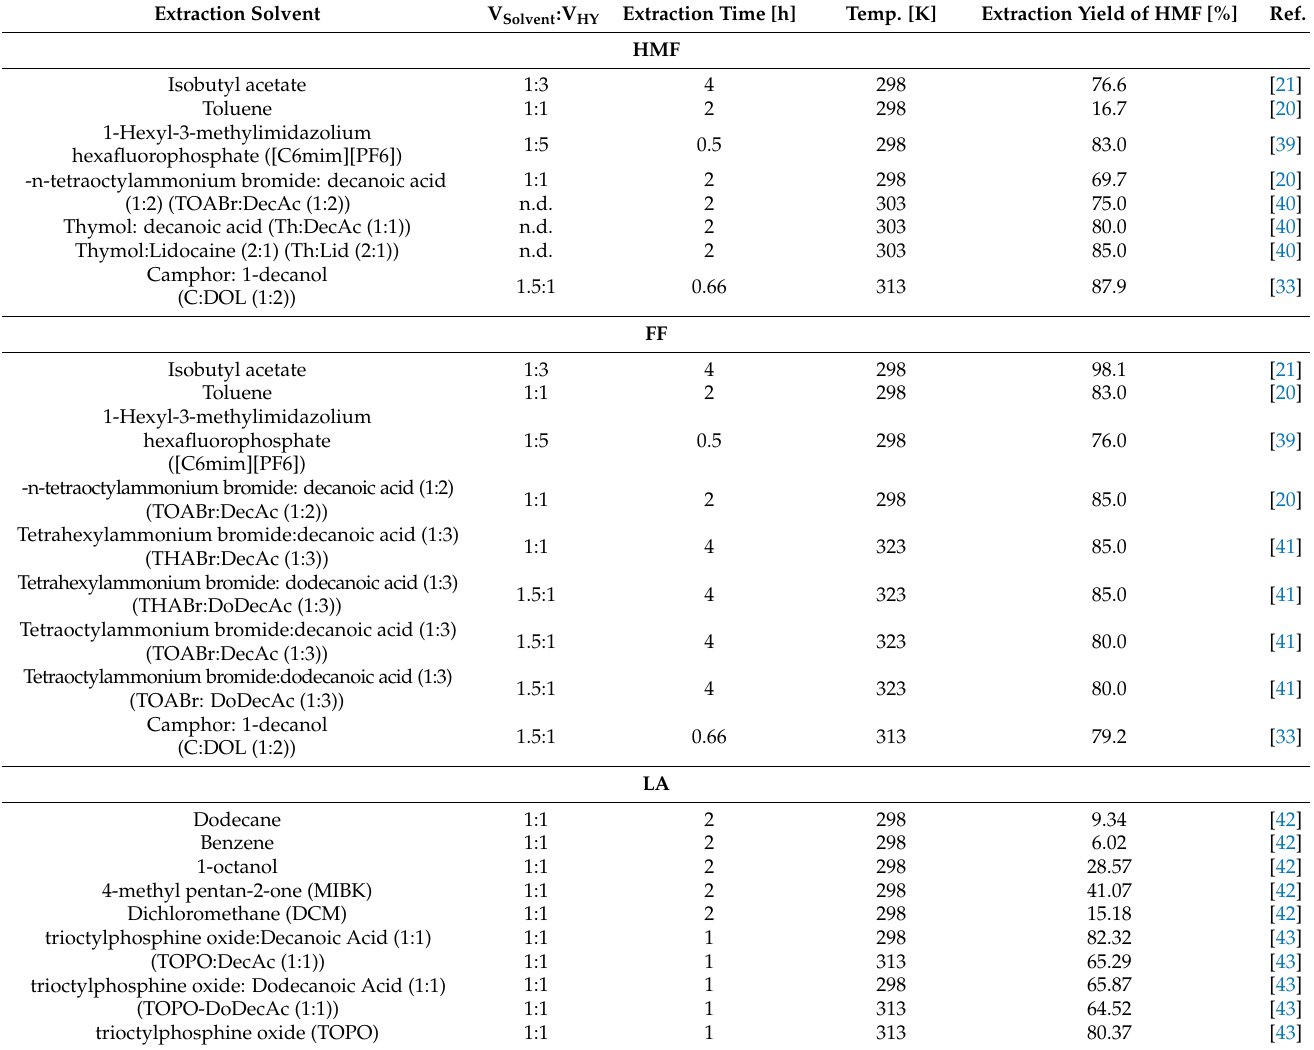
Table 7. Comparison of the developed extraction procedure based on DES with other